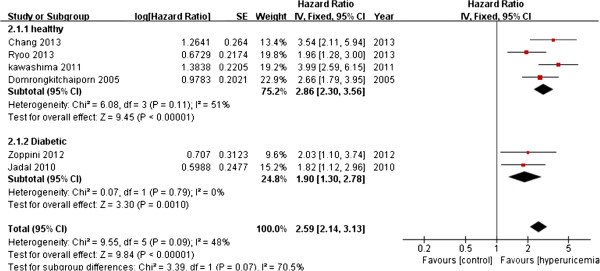
Forest plot of association between hyperuricemia and new-onset CKD.